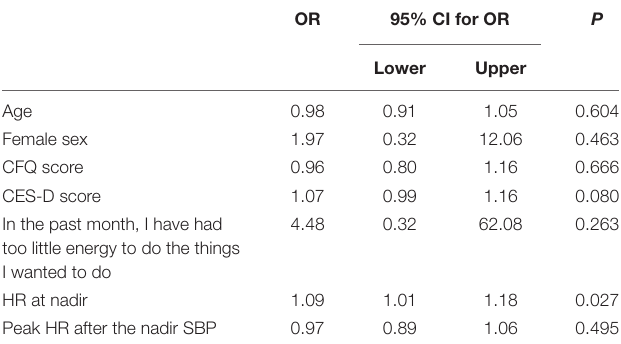
TABLE 3 | | Logistic regression model with predictors of OI AS